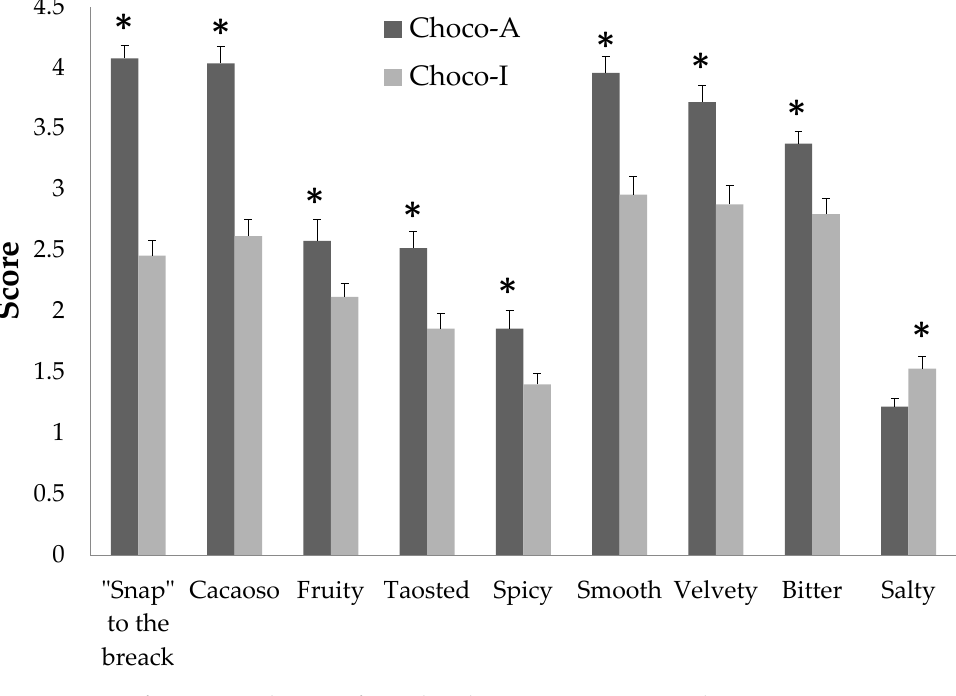
Figure 4. Score of sensory evaluation of two chocolates. Data are expressed as means ± SEM. * p < 0.05 Choco-A vs. Choco-I.